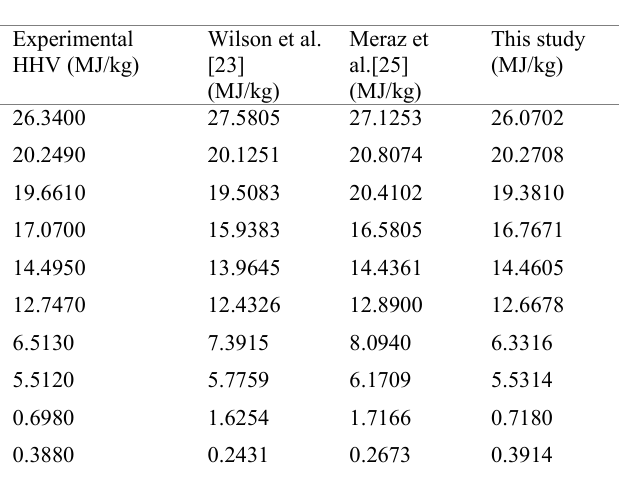
Table 5. Experimental and Predicted HHV based on different